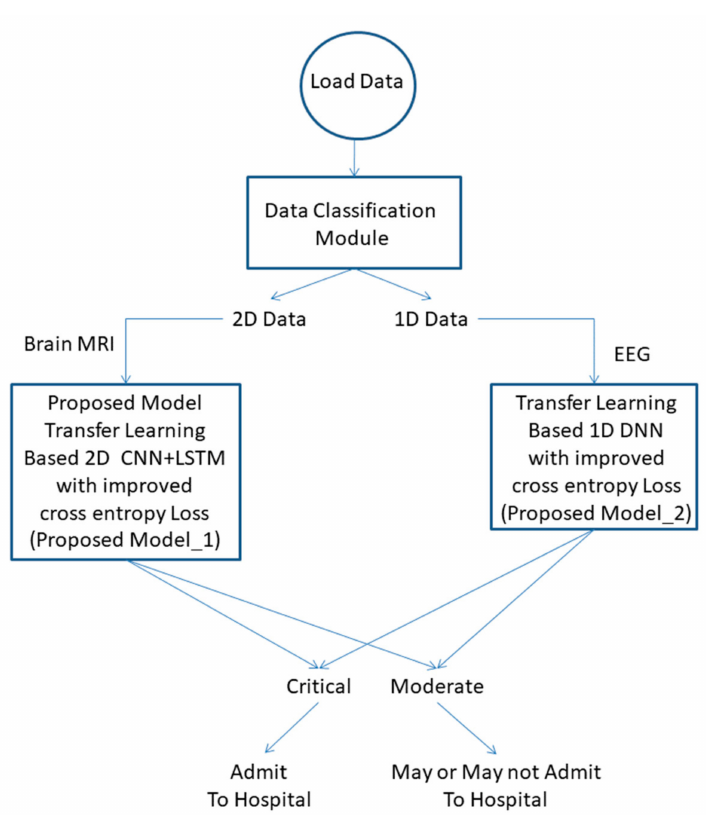
Figure 4. Block diagram of the proposed diagnosis